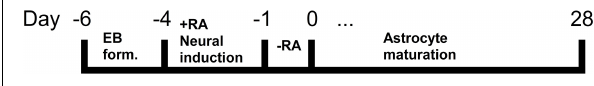
FIGURE 1 | Schematic representation of the protocol used for the differentiation of mouse embryonic stem cell lines (mESCs) into astrocytes over a total time of 2–5 weeks. Mouse ESCs were used to generate embryoid bodies (EBs), which were seeded onto laminated glass coverslips. Migrating astrocytes were detected and labeled from DIV 7 to DIV